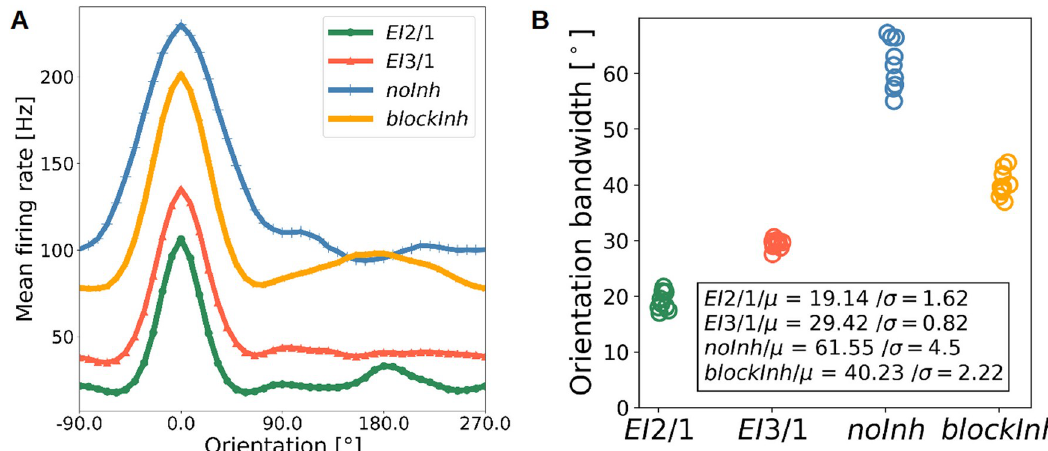
Fig 6. Inhibition controls tuning curve sharpening. A Average tuning curve of all excitatory cells in the EI 2/1 model, the corresponding counterpart with blocked inhibition, and the no inhibition model. B The orientation bandwidth (OBW) of cells in all three models. Every point represents the average OBW resulting from model simulation. Smaller OBW values correspond to narrower tuning curves. As expected, the EI 2/1 model (green) shows the narrowest tuning curves. The slightly reduced inhibitory strength in the EI 3/1 model (red) leads to moderately broader tuning curves. Fully blocking inhibition post-learning leads to both wider tuning curves and increased baseline activity in the blockInh model (yellow). The broadest tuning curves and highest baseline activity were observed in the noInh model (blue), which produced relatively large receptive